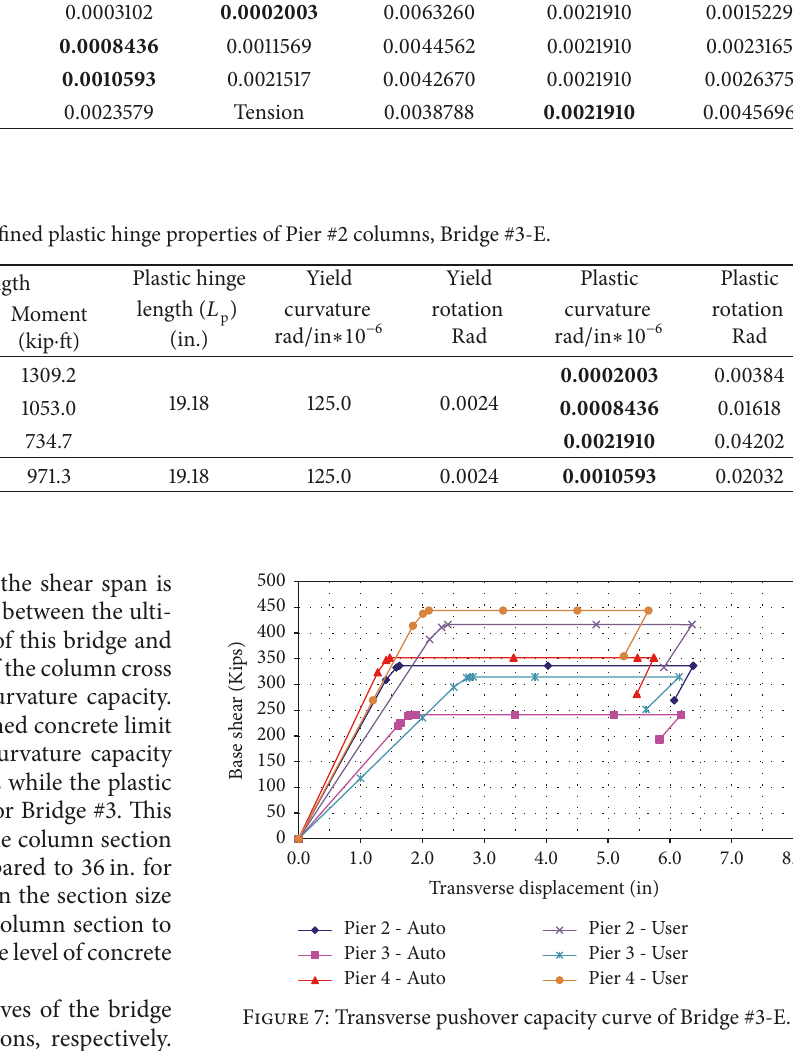
moment capacity is equal to 901.3 k ⋅ ft using the automated- hinge model in SAP2000. The corresponding values using the user-defined model are equal to 0.84 × 10 −3 rad/in. and 1053.0 k ⋅ ft,